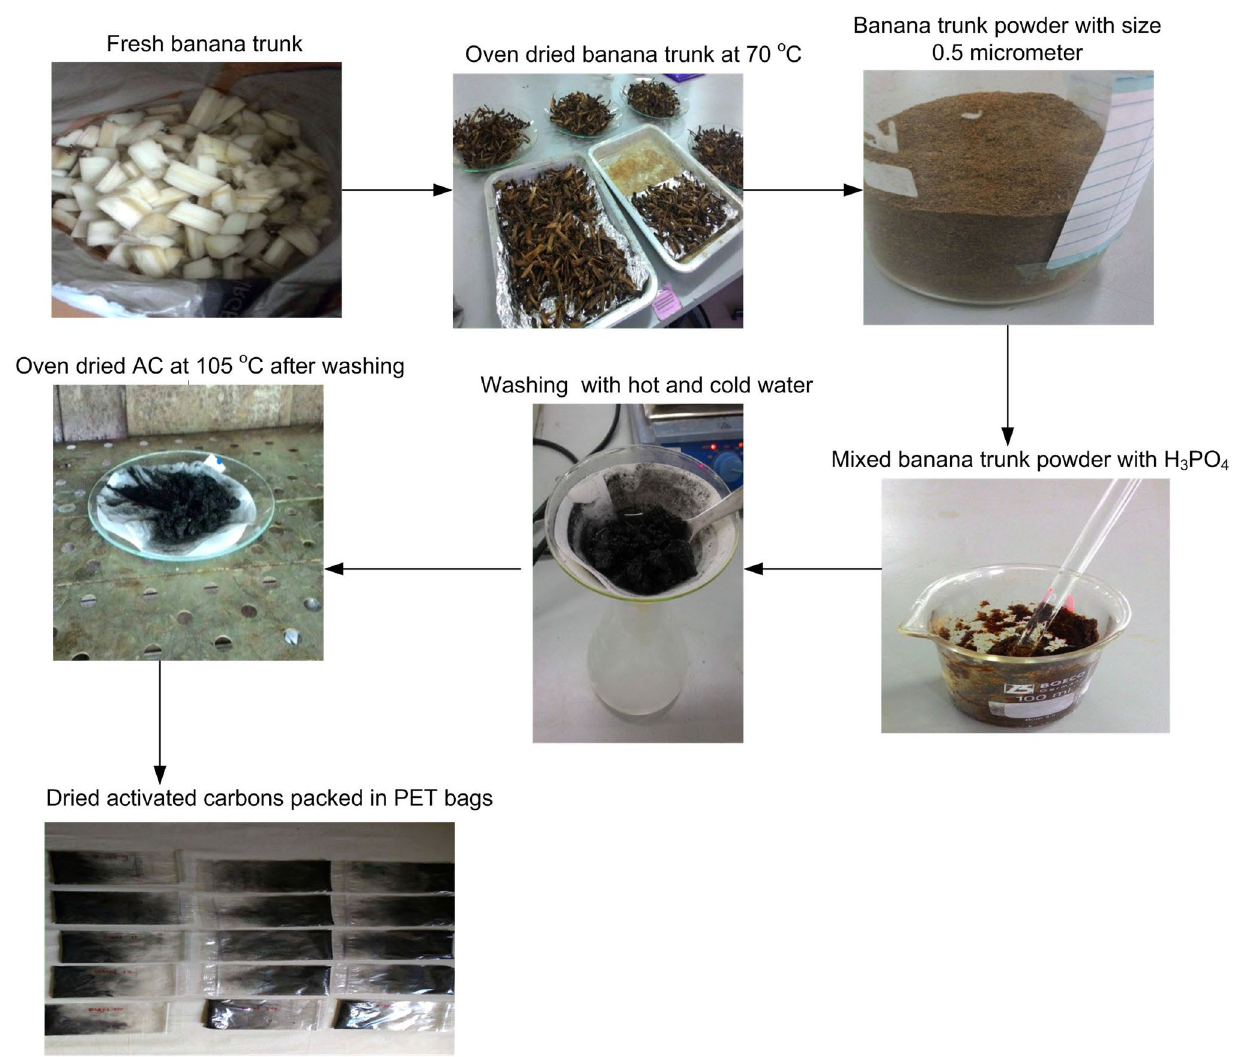
Fig. 1 Schematic representation of banana trunk drying and its conversion into activated carbon Table 1 Levels and ranges of independent variables used during the experiments